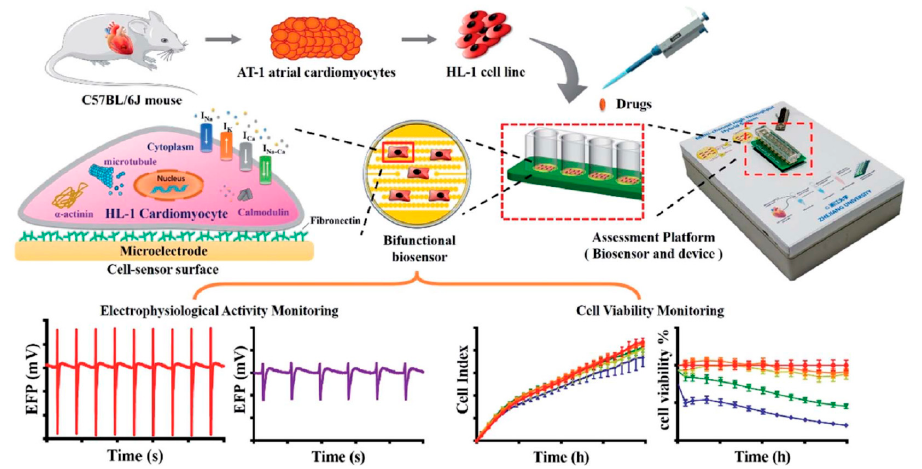
Figure 13. Schematic diagram of the drug-induced cardiac side-effect assessment platform with the CBI system and long-term electrophysiology recording platform. Reprinted from Gu et al. [96] with permission from Royal Society of Chemistry.